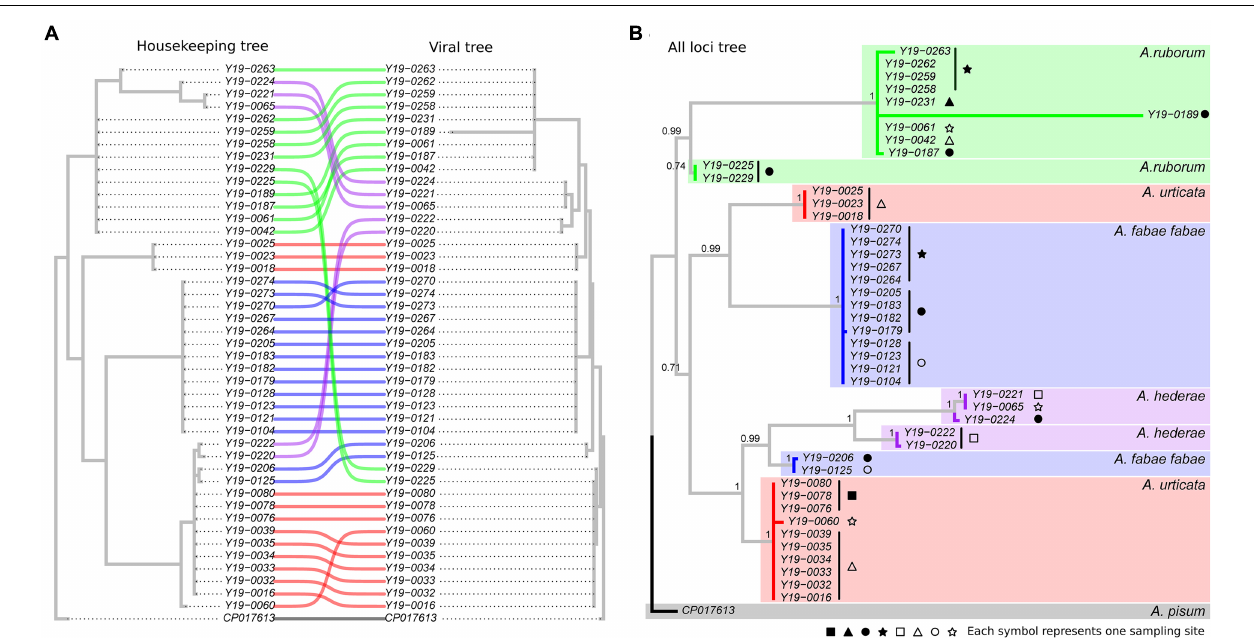
FIGURE 3 | Comparative phylogenies of concatenated housekeeping loci facing viral APSE loci (A) and consensus phylogeny of all loci combined (B) . Numbers indicate branch support, as a posterior probability computed out of 5,000 sampled trees. Colors match the aphid host species of each Hamiltonella sample. Symbols at the tip of the branches indicate different sampling sites (see Supplementary Table 5 for detailed